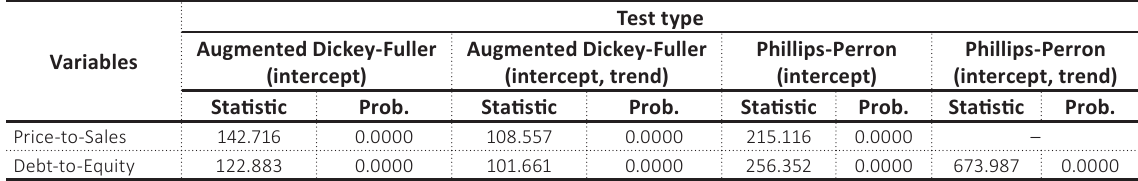
Table 5. Stationarity test results for first differenced variables